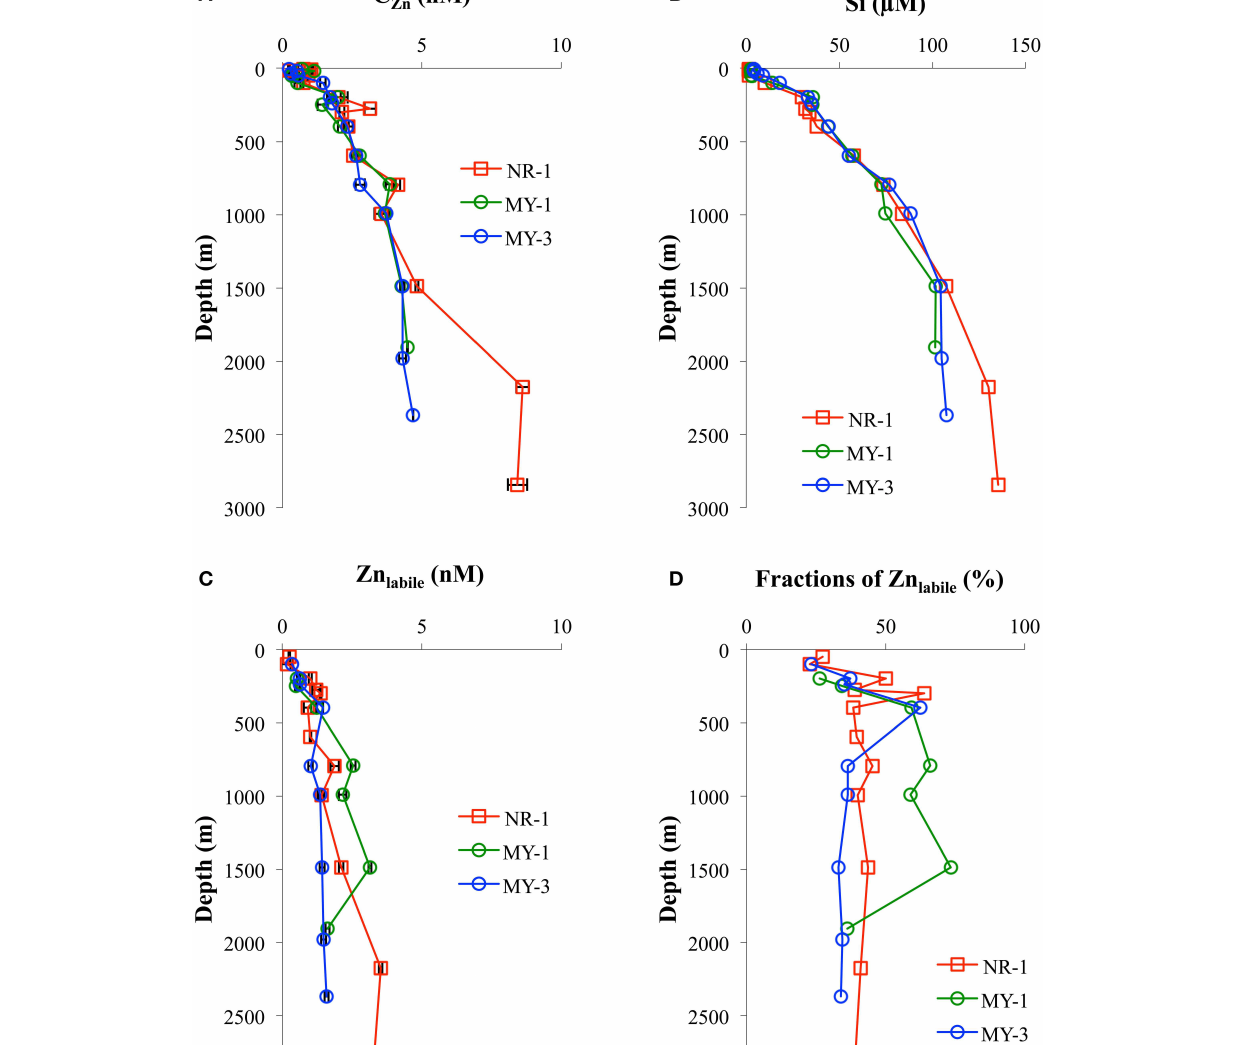
northeastern Indian Ocean (NR-1), the Zn titration for most of the samples showed a linear increase with added Zn 2 + , indicating that the natural ligands in the sample were already almost saturated with Zn. Thus, only one estimate of log K ′ ZnL , Zn 2 + could be obtained from the titration data for NR-1. The C L and log K ′ in the northeastern Indian Ocean ZnL , Zn 2 + (NR-1, 17 m) were 0.5 nM and 10.0, whereas those of the Andaman Sea (MY-1–MY-6) were 0.4–0.9 nM and 9.6–11.4 ( Table 1 ), respectively. In the Andaman Sea, the highest C L , 0.9 nM, was observed at both MY-1 and MY-6 ( Table 1 ). The resultant free Zn 2 + concentrations in the northeastern Indian Ocean and the Andaman Sea were 0.047 nM and 0.002–0.066 nM, respectively ( Table 1